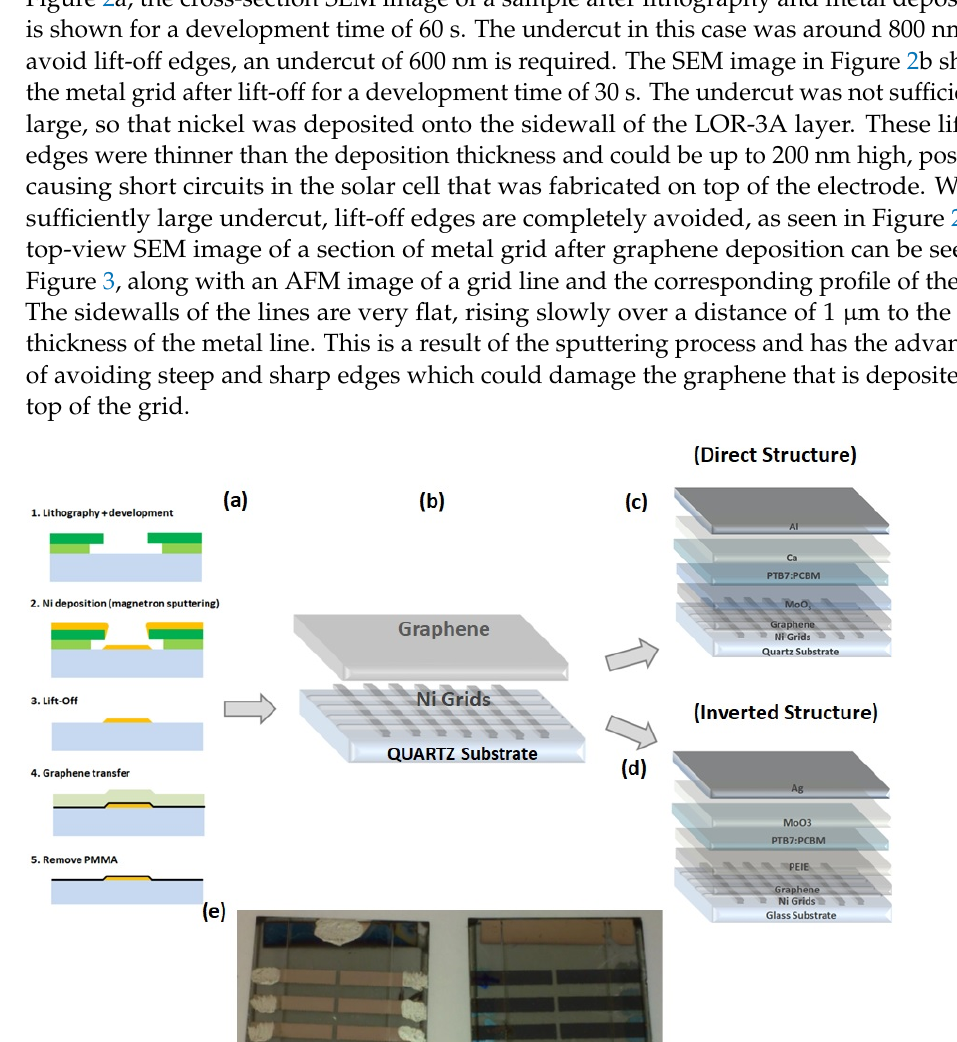
Figure 2. ( a ) Cross section SEM image of a sample after lithography and metal deposition before lift- off. ( b ) Example of a lift-off edge due to an insufficiently large undercut. ( c ) Example of a grid line without a lift-off edge.